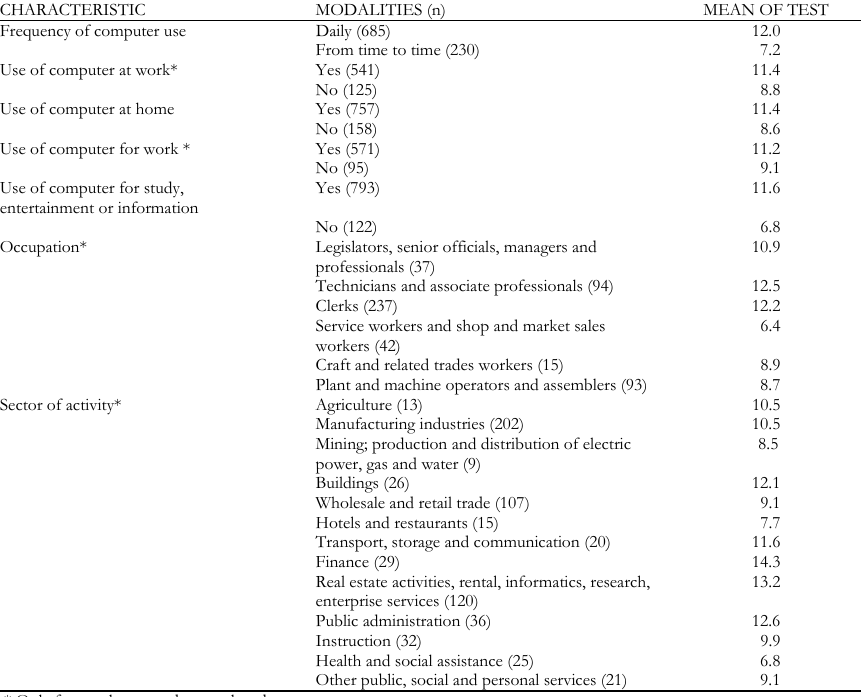
Means calculated for the modalities of the relevant endogenous characteristics